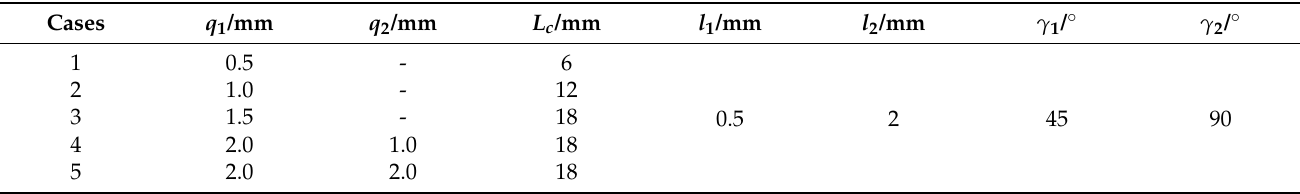
Figure 14. Different propagation cases of the spatial crack: ( a ) distribution of crack depth q ( z ); ( b ) distribution of crack height l ( z ). Table 2. Parameters of different crack propagation cases.